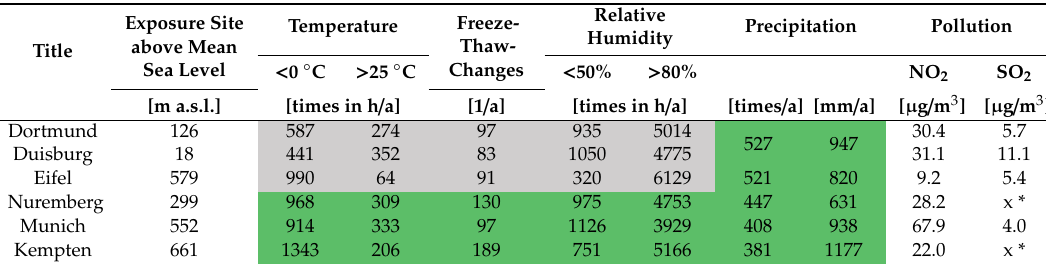
Table 4. Climatic data for the weathering locations, mean values over the last 10 years of exposure (a = year, h = hours).